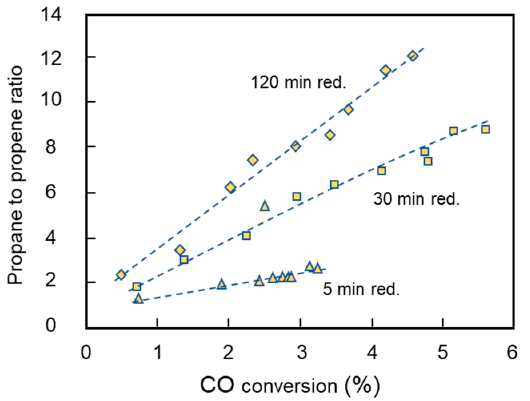
Figure 6. Propane to propene ratio as a function of CO conversion on one fresh Co foil run continu- ously in the sequence of 5-, 120-, and 30-min. Conditions: T = 220 ◦ C; P = 1 bar; H 2 /CO = 3; total ously in the sequence of 5-, 120-, and 30-min. Conditions: T = 220 °C; P = 1 bar; H 2 /CO = 3; total flow = 3 Nml/min; TOS for each FT-synthesis: 10 min. flow = 3 NmL/min; TOS for each FT-synthesis: 10